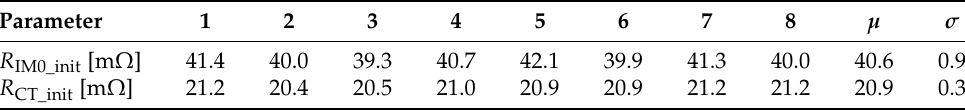
Table 3. R IM0 and R CT of the 8 cells before aging.